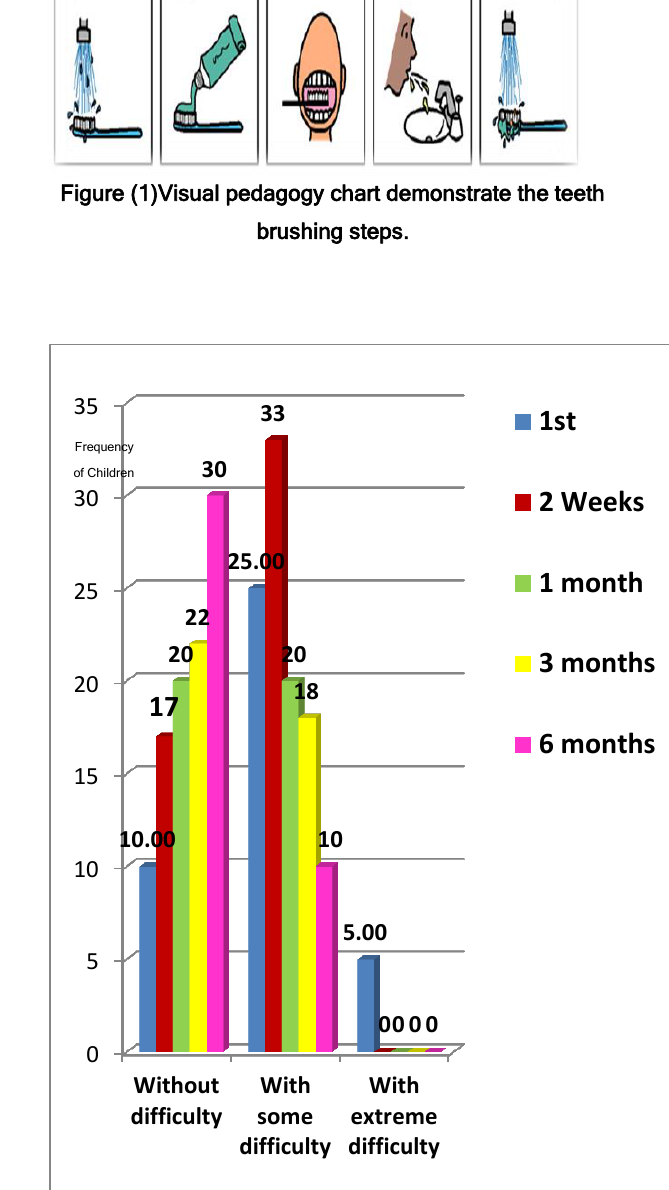
Figure (2)Distribution of treatment acceptance of autistic children in dental sitting in different visit recalls assessment by the dentist.p≤ 0.05 between groups. Discussion:: Physical restraint, reinforcement and parent present were used with all children in all visits